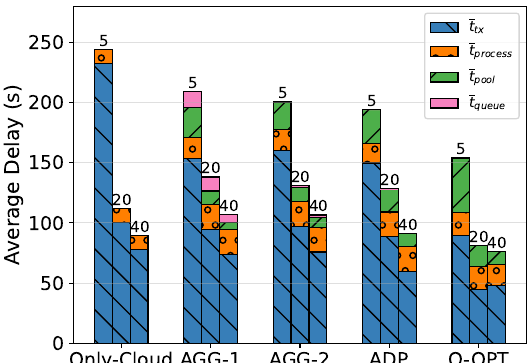
Figure 8. Impact of task inter-arrival time on task delay composition.